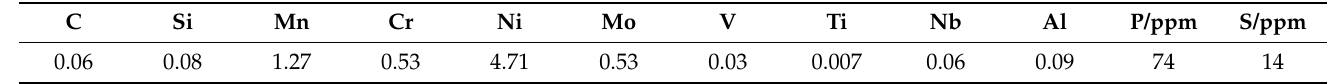
Table 1. Chemical compositions of the HSLA steel (wt%).